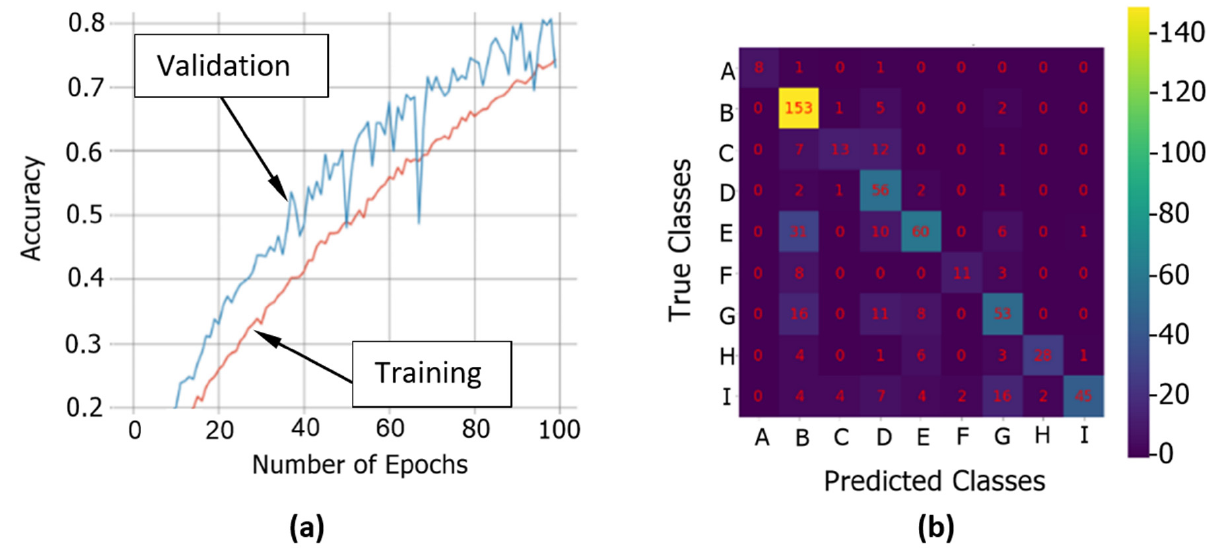
Figure 9. Graphics for EfficientNetV2M architecture. ( a ) Training and validation accuracy ( b ) Con- fusion matrix for Test set. Apple variety legend: (A) Blanquina, (B) Carrió, (C) Florina, (D) Fuentes, (E) Prieta, (F) Raxao, (G) Reineta Encarnada, (H) Reineta Pinta, (I) Reineta Roja del Canadá.